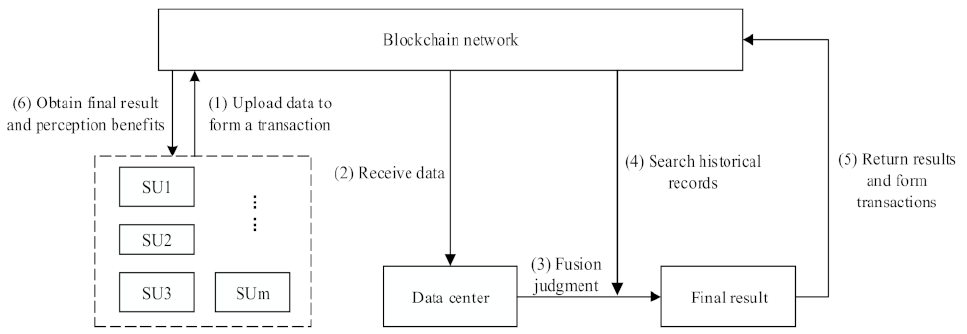
Figure 5. CSS model based on